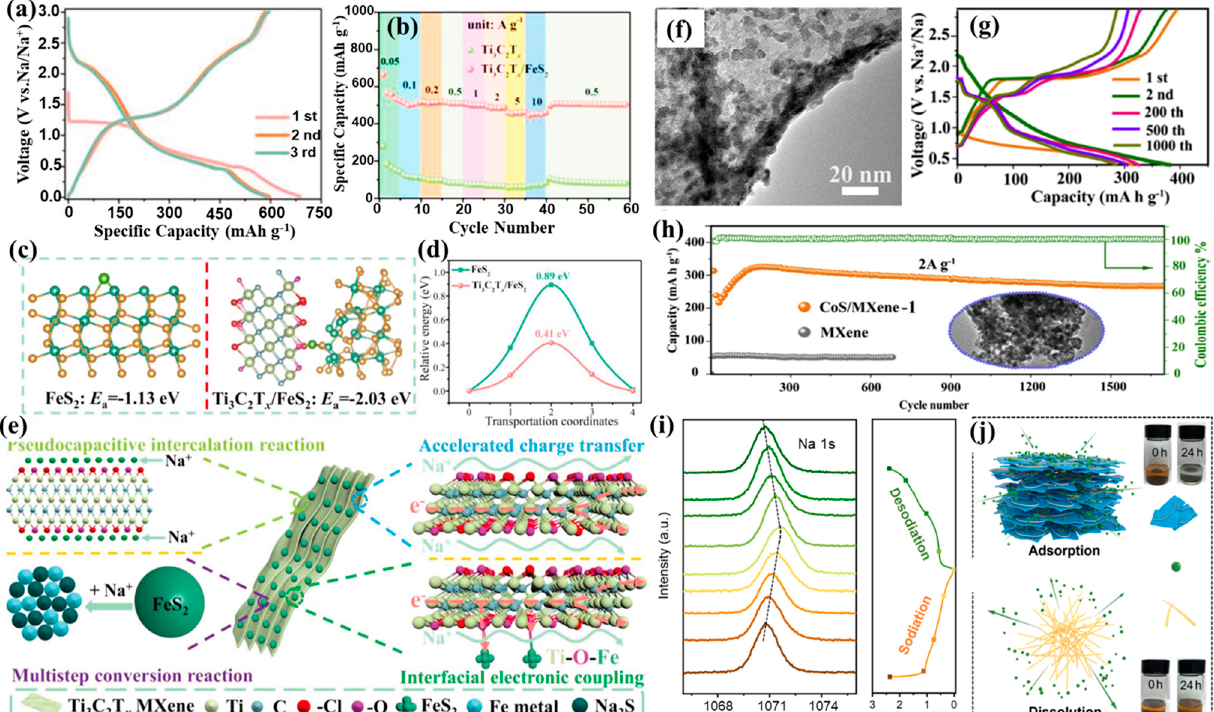
Figure 7 . ( a , b ) Discharge–charge profiles and rate performance of a Ti 3 C 2 T x /FeS 2 electrode. ( c , d ) The Na adsorption energy and Na migration energy barriers of Ti 3 C 2 T x /FeS 2 and FeS 2 . ( e ) Schematics